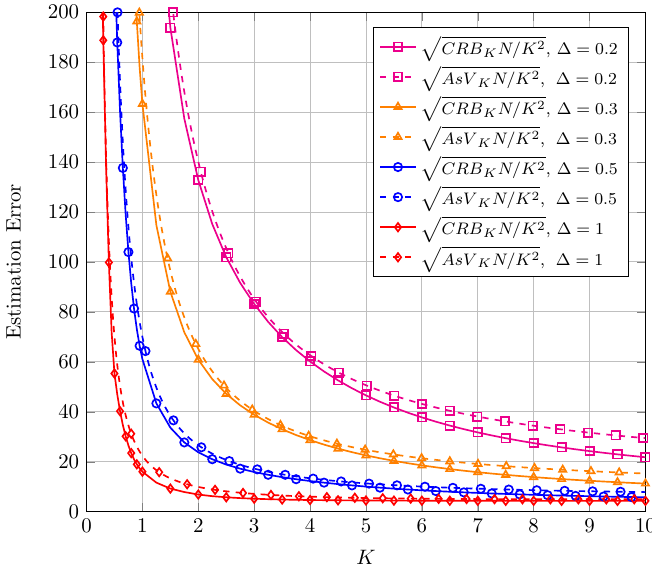
Figure 1. Sqrt-normalized CRB K and AsV K as a function of K , for different values of ∆ .